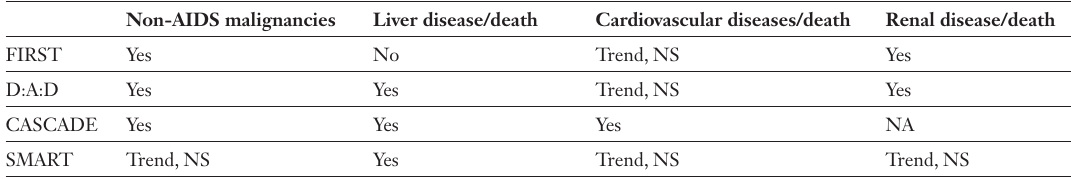
Association between current CD4-T-cell count and non-AIDS complications